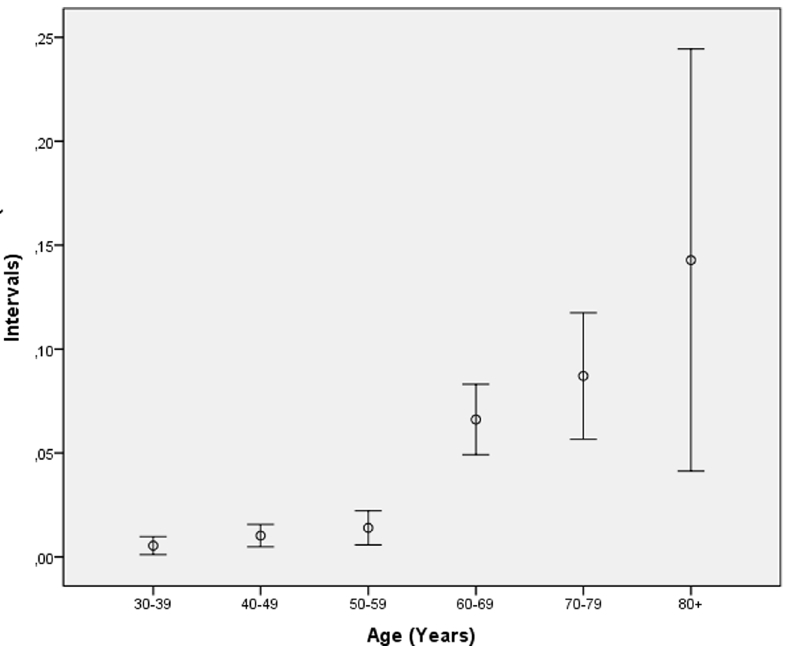
Figure 1. Prevalence of Glaucoma (As defined by Ophthalmoscopy) in the Central India Eye and Medical Study.